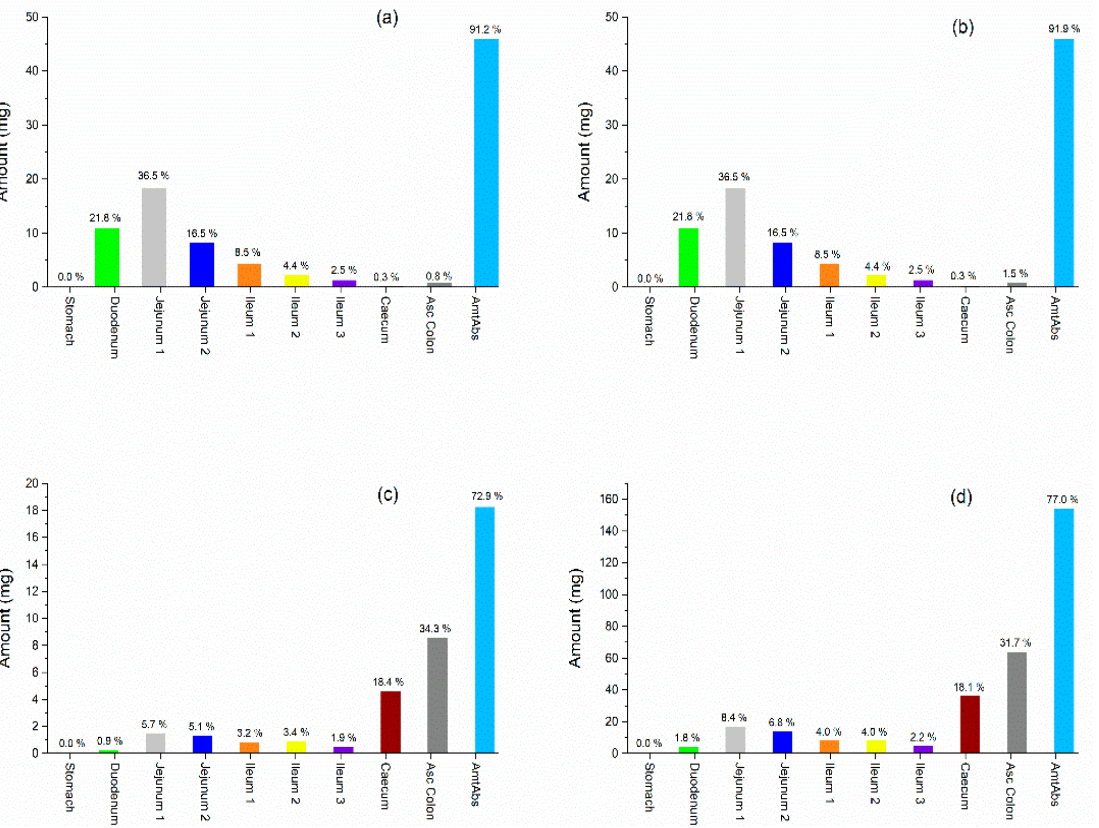
Figure 9. Prediction of regional absorption of metoprolol in gastrointestinal tract using different formulations: 50 mg IR tablet ( a ); 50 mg IR oral solution ( b ); 25 mg CR tablet-A ( c ); 200 mg CR tablet-C ( d ). Table 12. In vivo and in silico data of ER oral formulations in fasted and fed states, adopted to develop and validate the model, as well as their respective SC